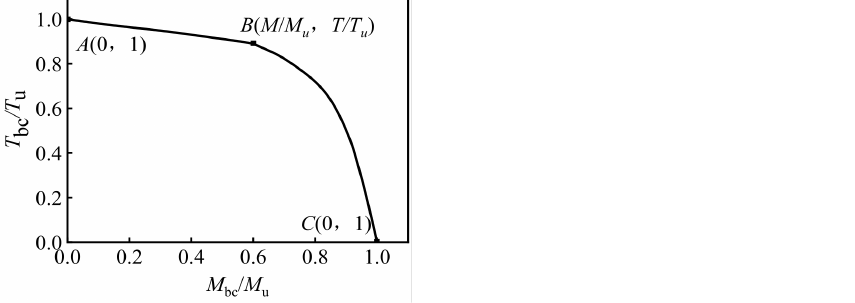
Figure 26. Typical M / M u - T / T u curve of concrete-filled CFRP steel tubular flexural torsional